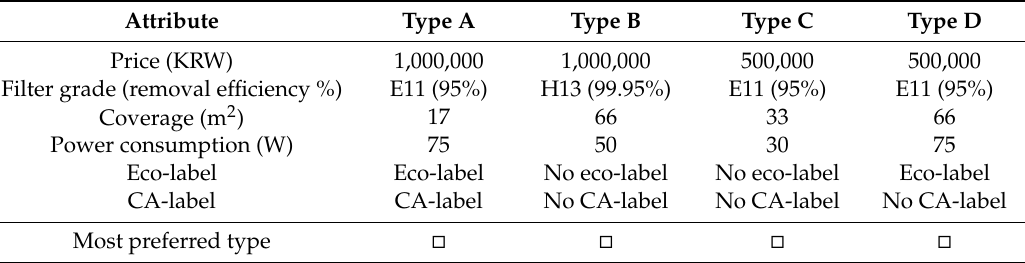
Table 3. Example choice